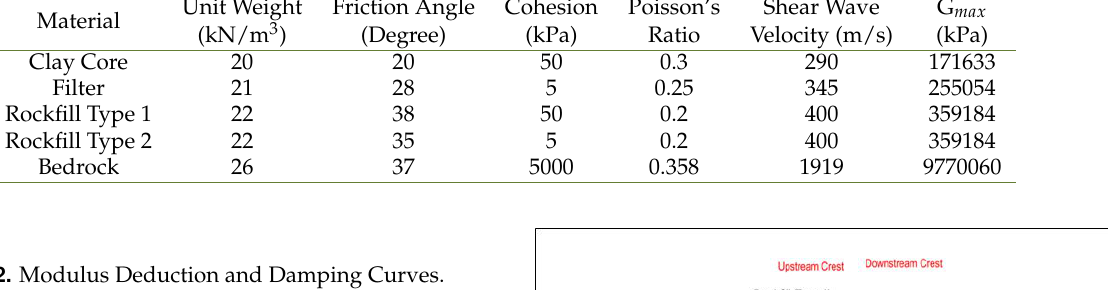
Table 2. Modulus Deduction and Damping Curves.